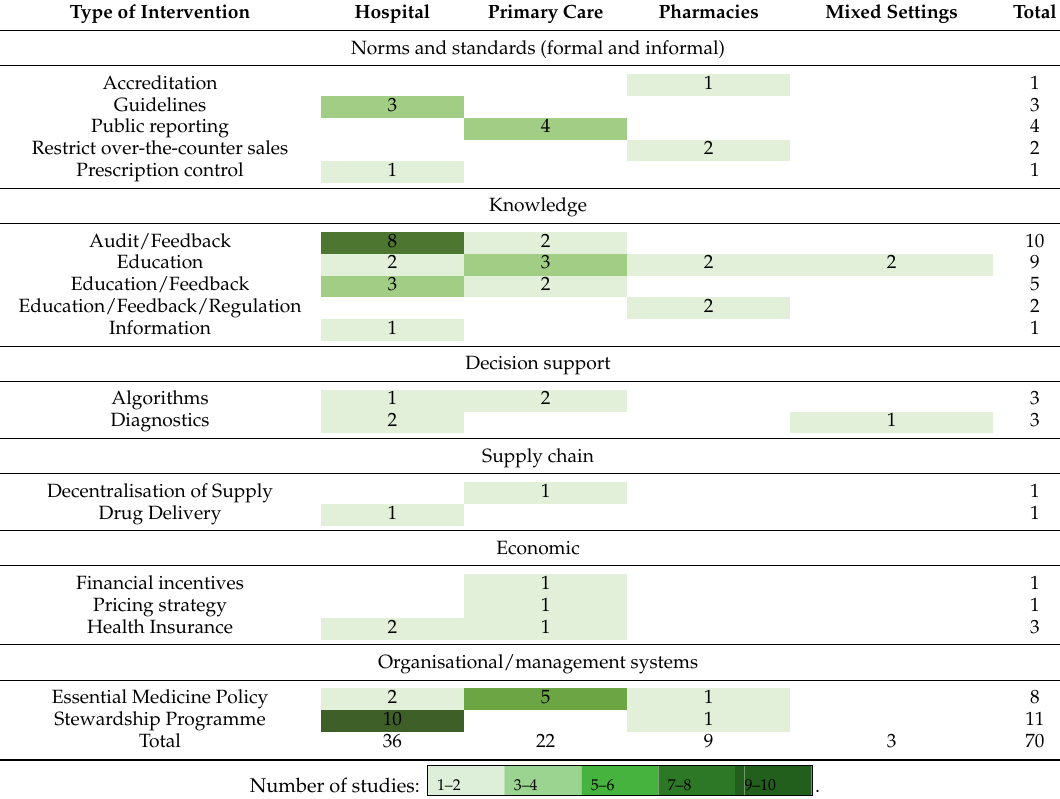
Table 4. Kinds of intervention, by setting.